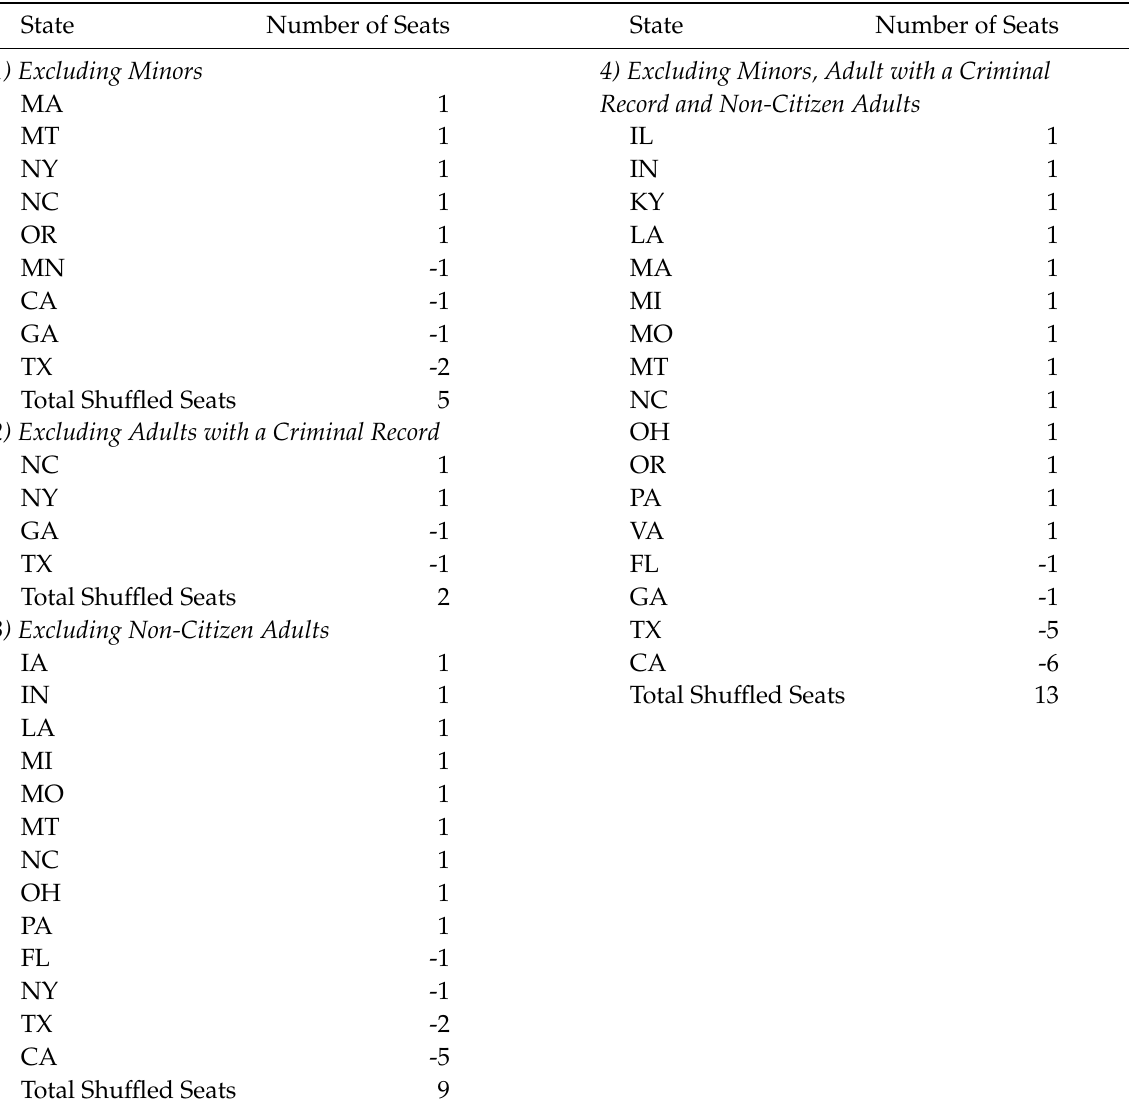
Table 3: 2010 Apportionment Based on 4 Exclusion Scenarios